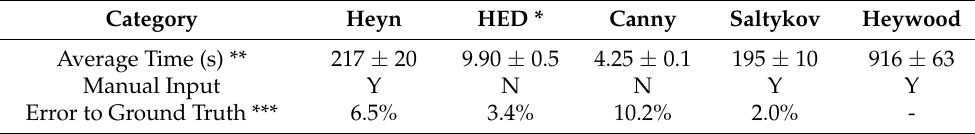
Table 1. Time requirements of different grain diameter analyses of one micrograph, in seconds. The Heywood diameter is set as the ground truth value and thus does not have an associated error. Category Heyn HED * Canny Saltykov Heywood Average Time (s) ** 217 ± 20 9.90 ± 0.5 4.25 ± 0.1 195 ± 10 916 ± 63 Manual Input Y N N Y Y Error to Ground Truth *** 6.5% 3.4% 10.2%